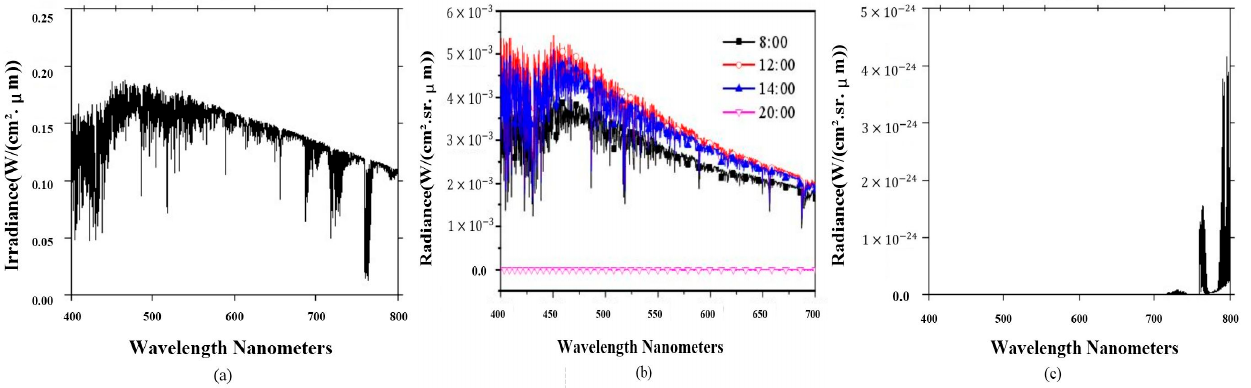
Figure A1. Sky and solar radiation: ( a ) solar irradiance; ( b ) the radiance of sky background radiation; ( c ) the radiance of atmospheric path.